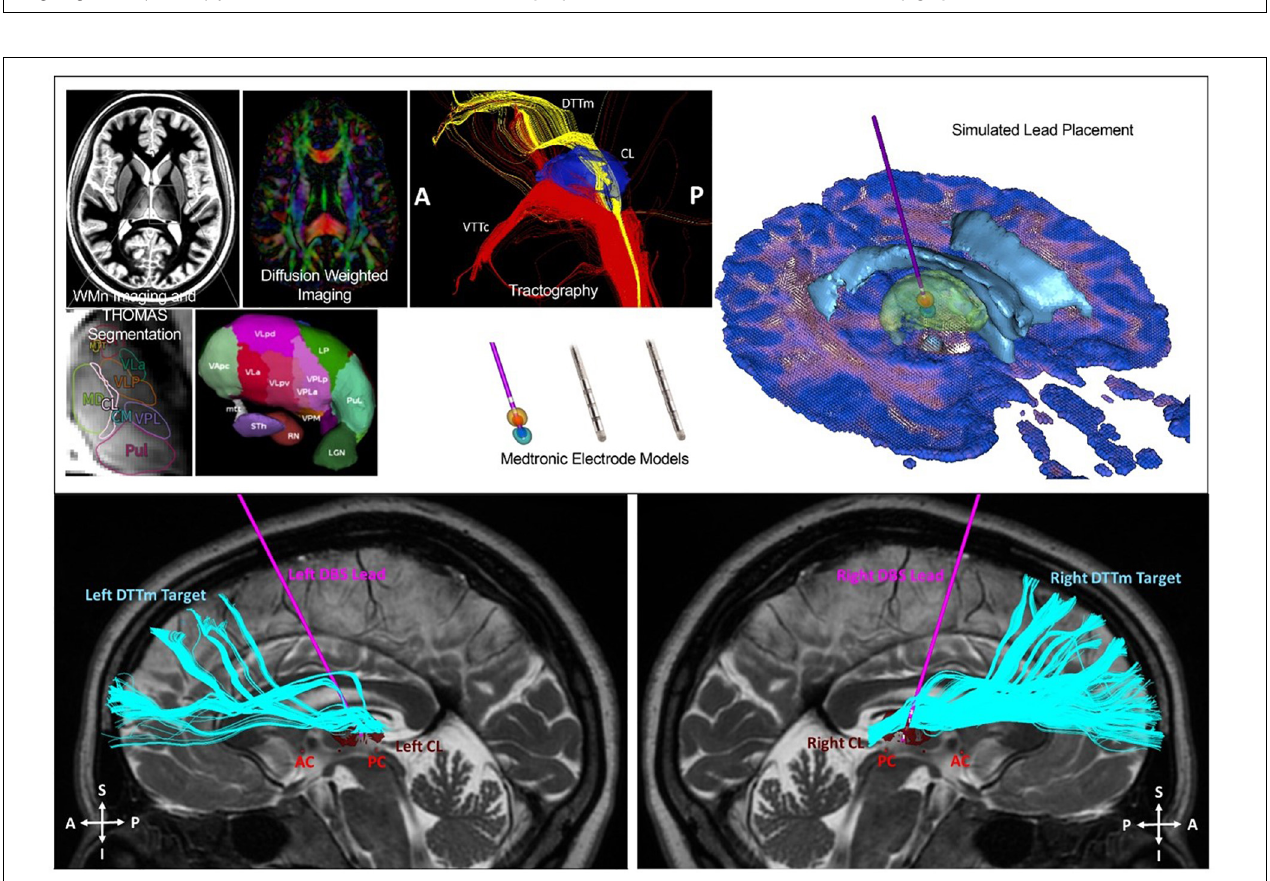
FIGURE 11 | Top image: Identification of the CL and DTTm. Automated patient-specific thalamic segmentation was performed to obtain detailed representations of the central lateral (CL) nucleus for use as a spatial filter to identify the DTTm projecting from the brainstem to the frontal cortex. Bottom image: Two Medtronic 3389 4 contact DBS leads were implanted into the CL nucleus under monitored anesthesia care with microelectrode mapping. The leads were attached to a right infraclavicular Activa PC + S pulse generator under general anesthesia in the same surgical session.